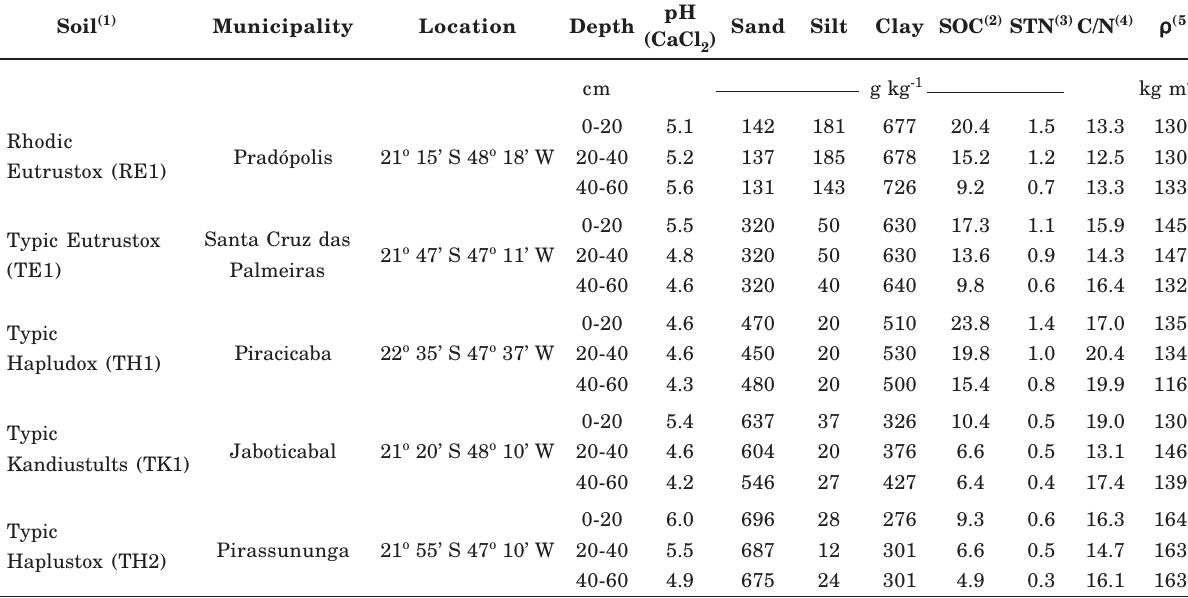
Table 1. Physical and chemical properties of soils under sugarcane in São Paulo State, Brazil, sampled in the layers 0-20, 20-40 and 40-60 Soil (1)